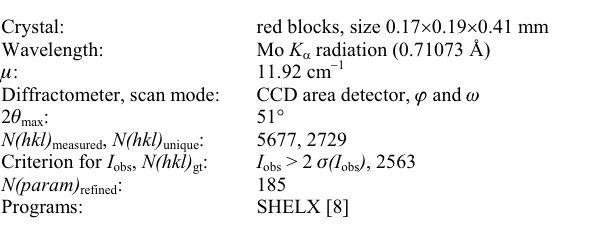
Table 1. Data collection and